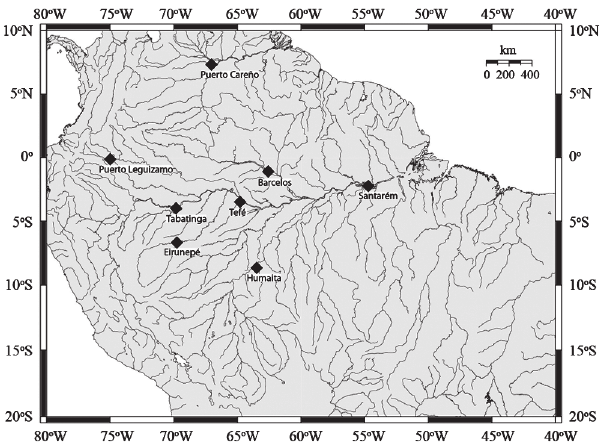
Fig. 1. Sampling localities in the Amazon and Orinoco basins of O. bicirrhossum and O. ferreirai . Base map was obtained from Online Map Creation (Geomar) currently available as Planiglobe